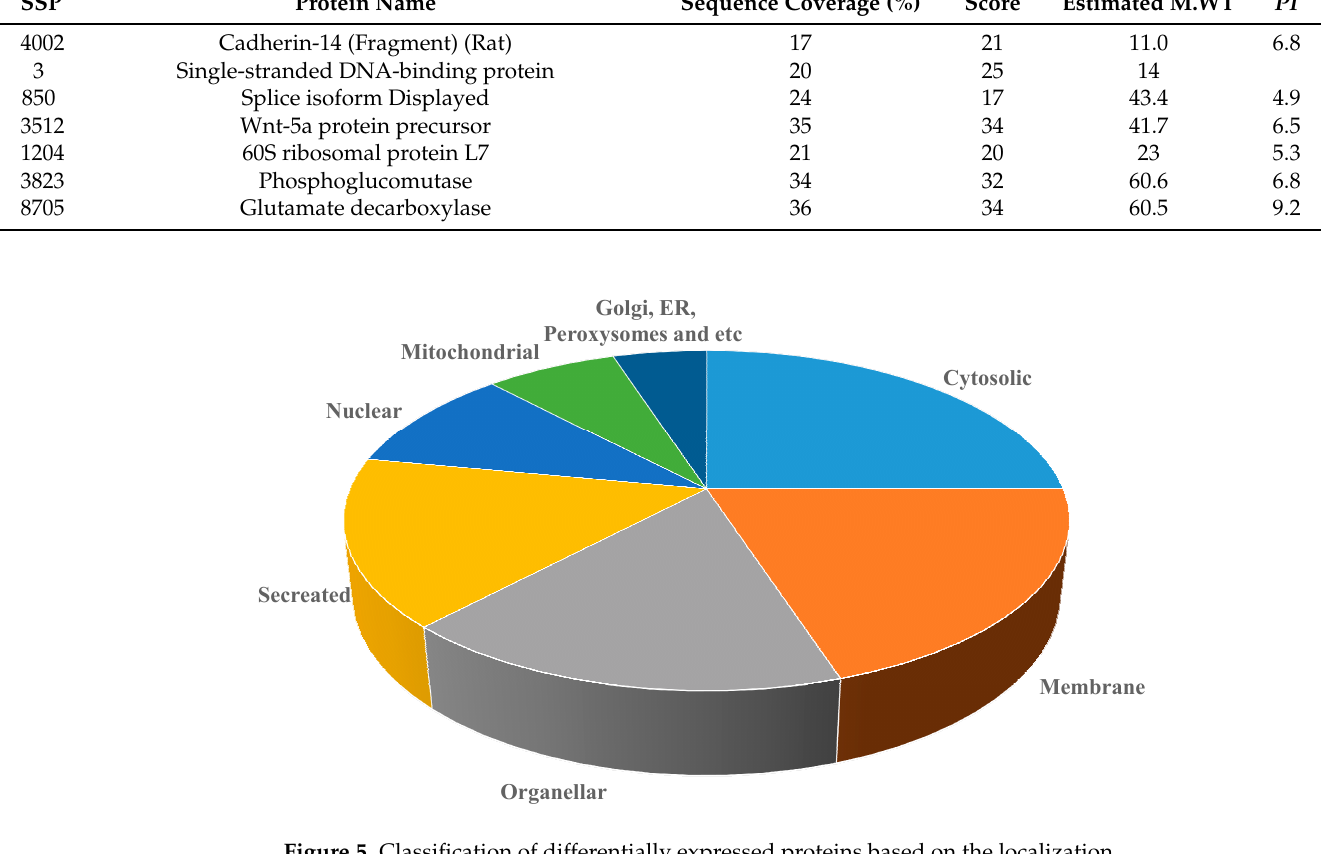
B Figure 6. Classification of proteins based on their putative function extracted from experimental rat livers. A —150 mg/kg of APAP-treated rats; B —1500 mg/kg of APAP-treated rats. Among the identified proteins in the toxicity induced rats, we have separated differentially expressed proteins that are known to play a vital role in the toxicity assessments, which are summarized in Table 4. Table 4. High differentially expressed proteins in rats received 1500 mg/kg of APAP. S. No